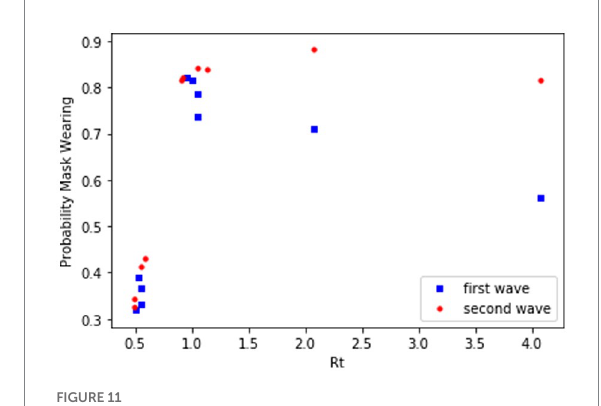
FIGURE 10 ACT-R simulation of the oscillation of reproduction number over two simulated waves of COVID-19 variants.